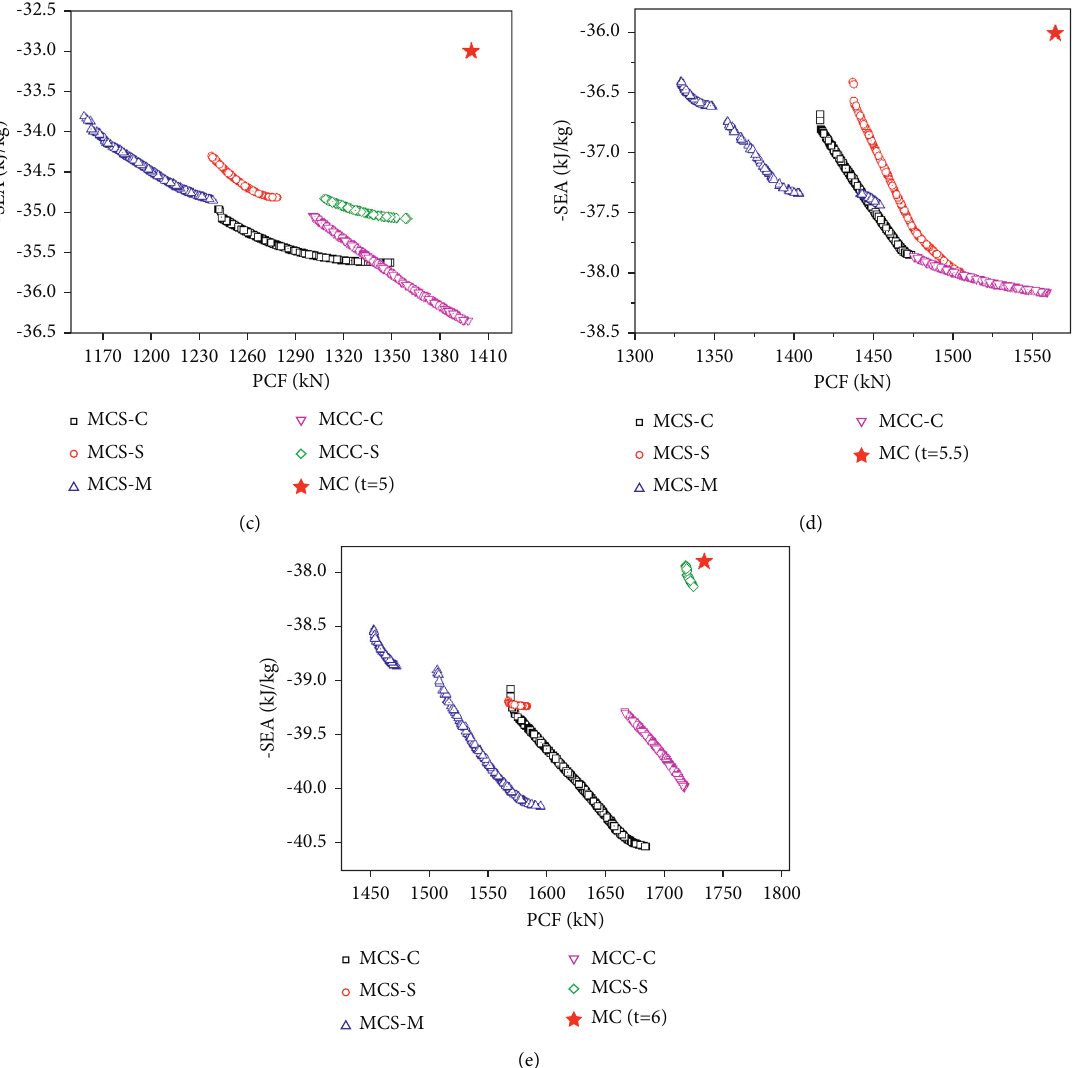
Figure 13: Pareto solutions for the windowed tubes with different thicknesses. (a) 4mm. (b) 4.5mm. (c) 5mm. (d) 5.5mm. (e)